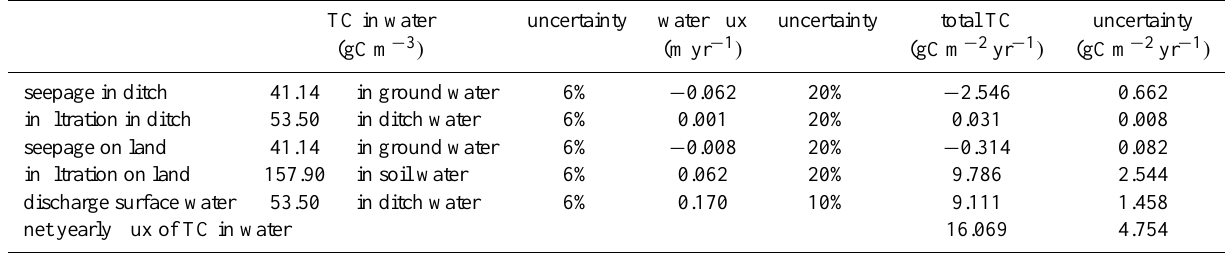
Table 8. Results of the water analyses for Total Carbon (TC) in the water, water fluxes over the year and annual fluxes of TC transported by water. TC in water uncertainty seepage in ditch 41.14 infiltration in ditch 53.50 seepage on land 41.14